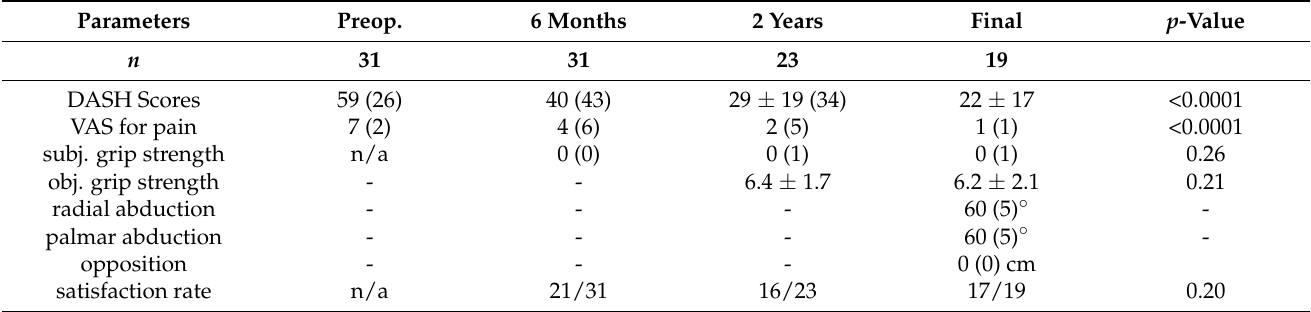
Table 2. Clinical outcomes including statistical